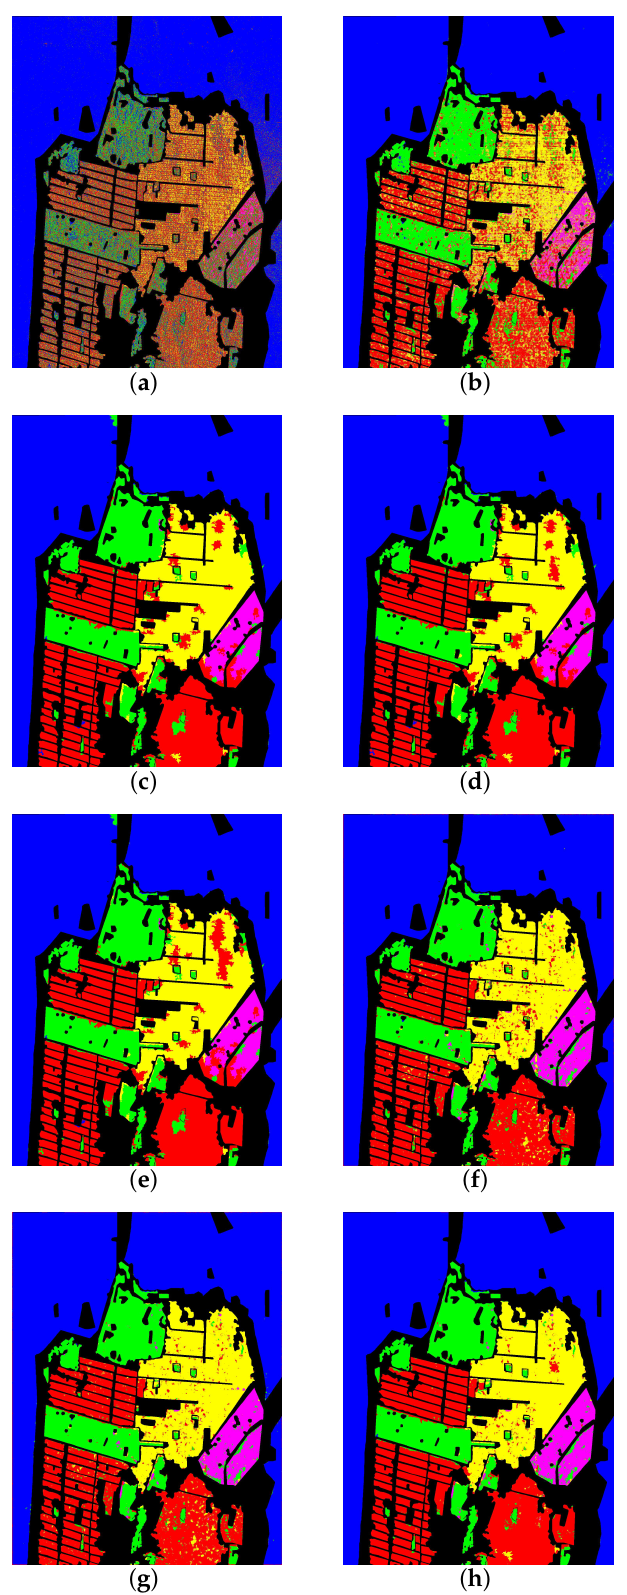
Figure 5. Classification results of San Francisco dataset overlaid with ground truth. ( a ) SVM ( b